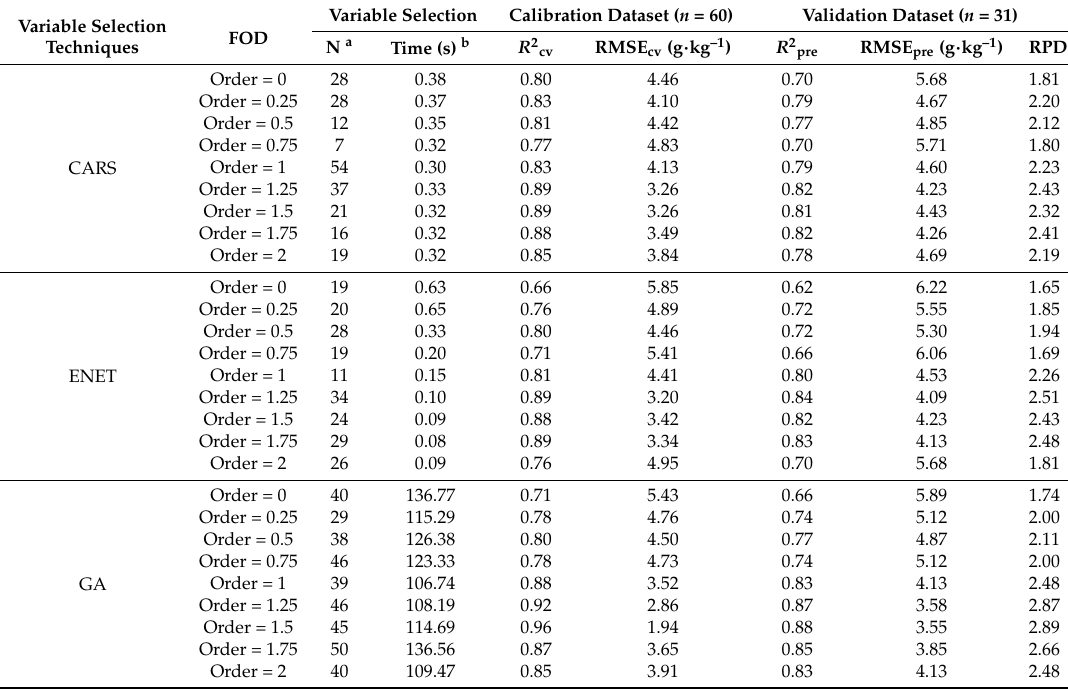
Table 2. Modeling results of CARS-SVM models, ENET-SVM models and GA-SVM models for SOM with different derivative order preprocessing